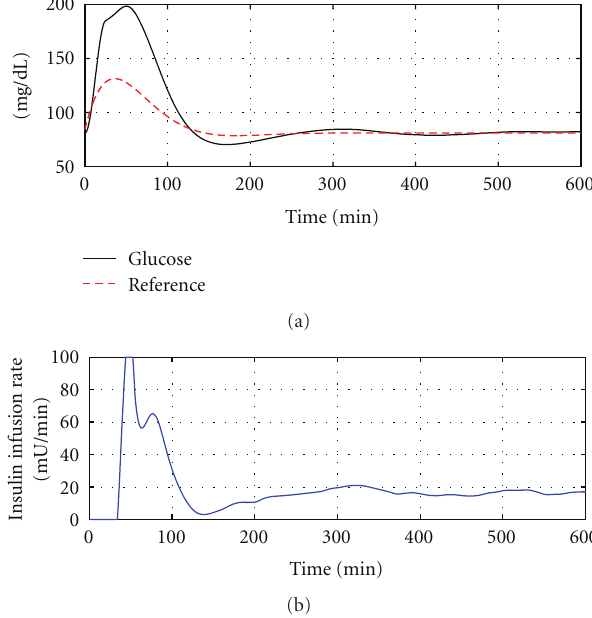
Figure 5: LPV control: glucose monitoring and insulin control under actuator delay and measurement